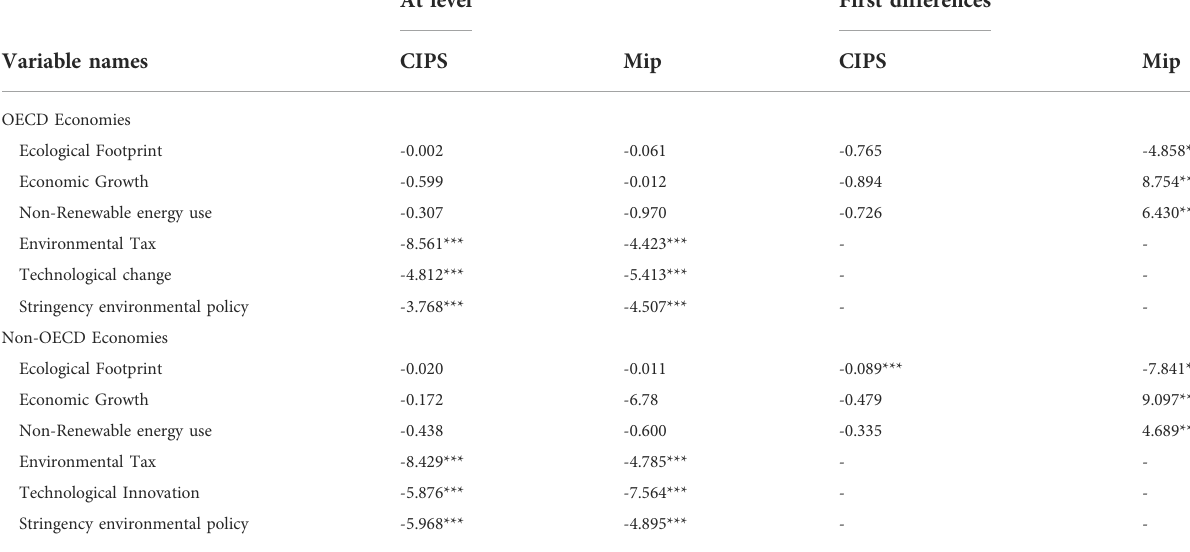
TABLE 4 Statistical analysis of Panel unit root test.